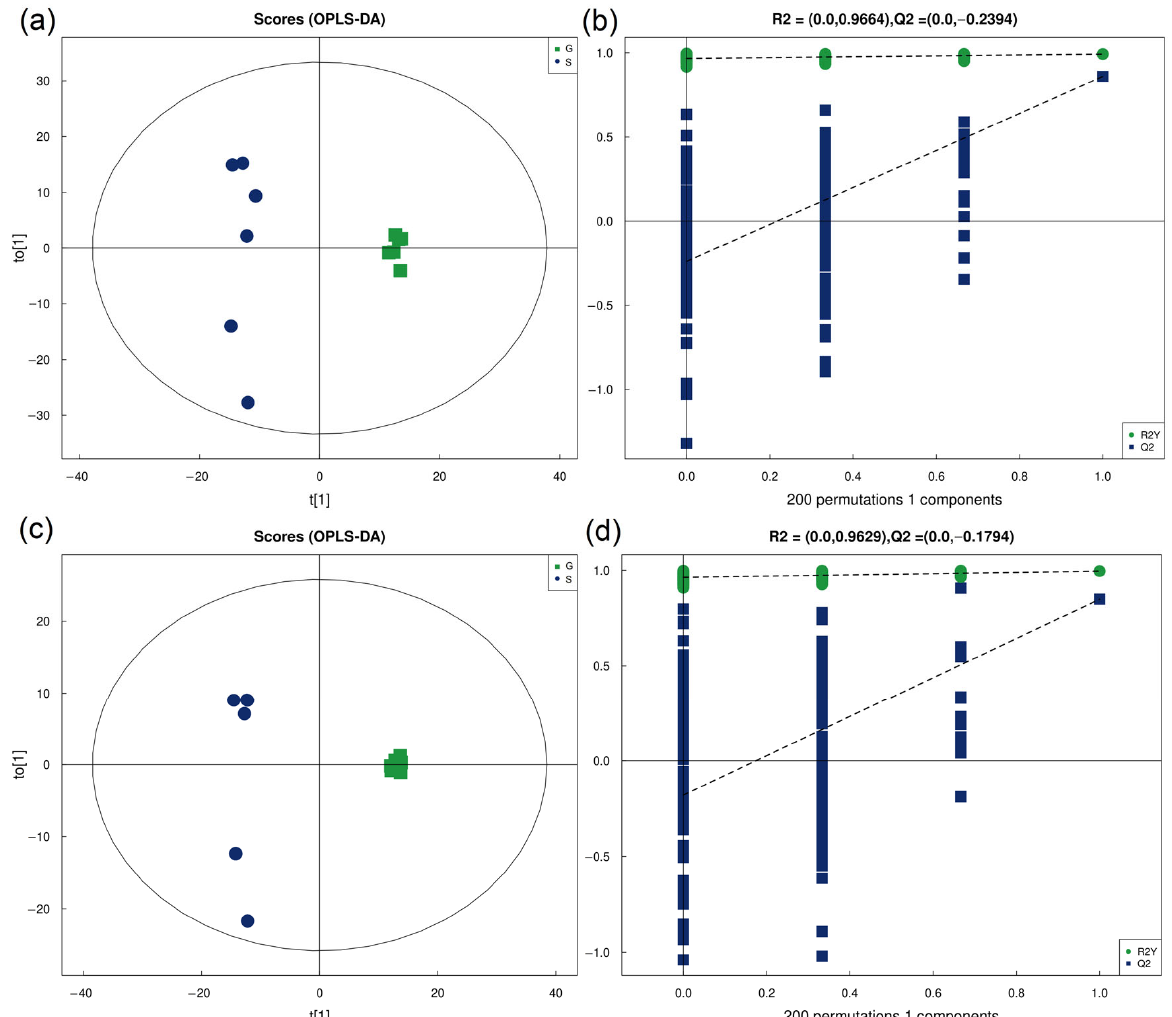
Figure 7. Orthogonal partial least-squares discriminant analysis (OPLS-DA) of the metabolome of gregarious armyworms and solitary armyworms. ( a ) Positive-ion mode score chart; ( b ) positive-ion mode permutation test; ( c ) negative-ion mode score chart; ( d ) negative-ion mode permutation test.